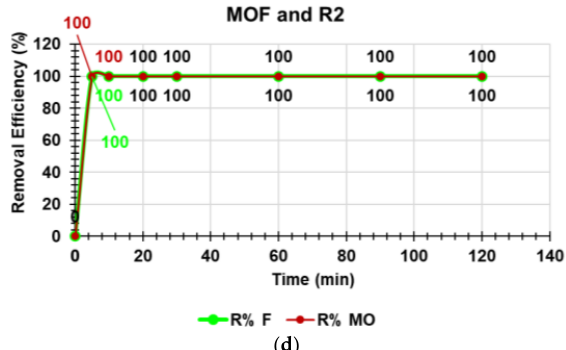
Figure 12. Cumulative removal efficiency (R%) (pH = 7.5; r.t.) of MO by R1 (red line) and R2 (blue line) ( a ); cumulative removal efficiency (R%) (pH = 7.5; r.t) of F by R1 (purple line) and R2 (green line) ( b ); cumulative removal efficiency (R%) (pH = 7.5; r.t) of MO (red line) + F (green line) (MOF) by R1 ( c ) and by R2 ( d ). F initial concentrations were 48.7 mg/L (R1), 49.4 mg/L (R2), 64.6 mg/L in MOF solution treated with R1, 64.9 mg/L in MOF solution treated with R2. MO initial concentrations were 50.9 mg/L (R1), 50.8 mg/L (R2), 39.6 mg/L in MOF solution treated with R1, 39.7 mg/L in MOF solution treated with R2.